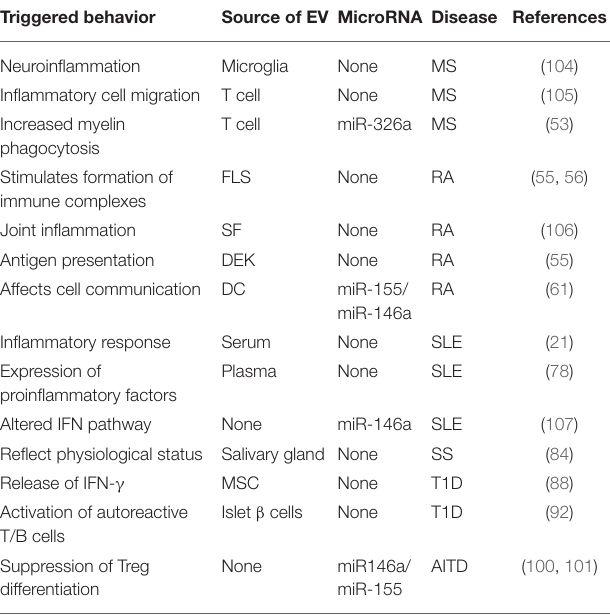
TABLE 1 | EVs involved in autoimmune diseases. Triggered